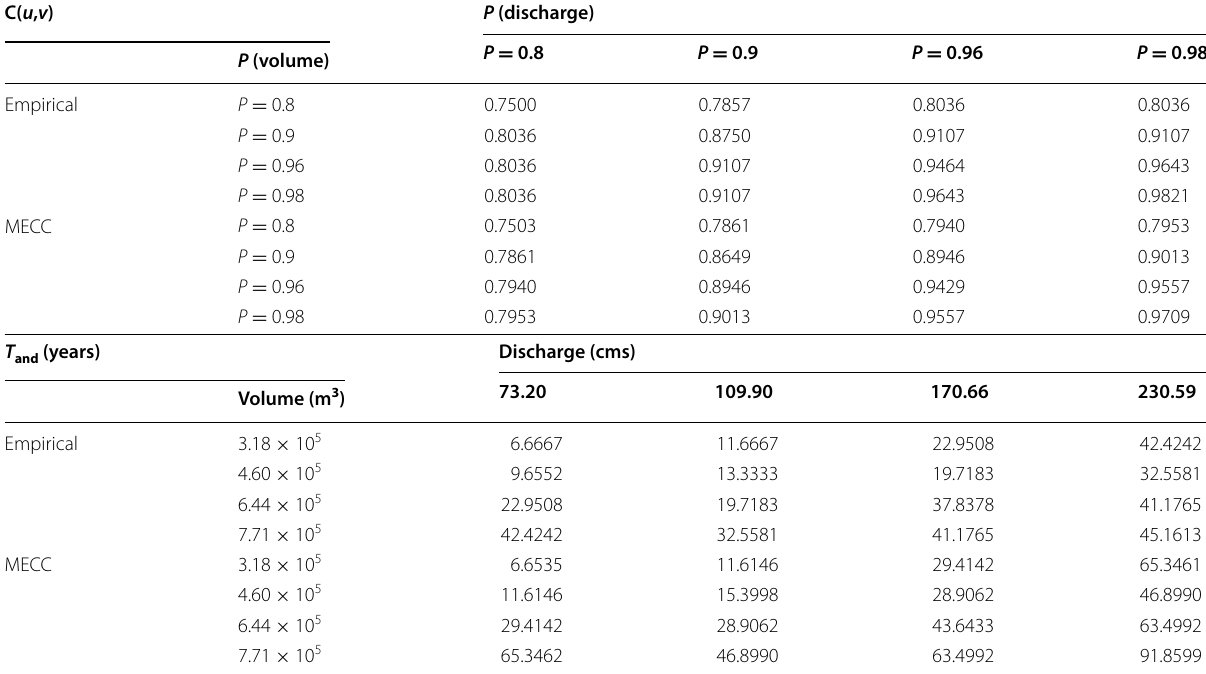
Table 8 Joint CDF and T estimated from the empirical copula and and